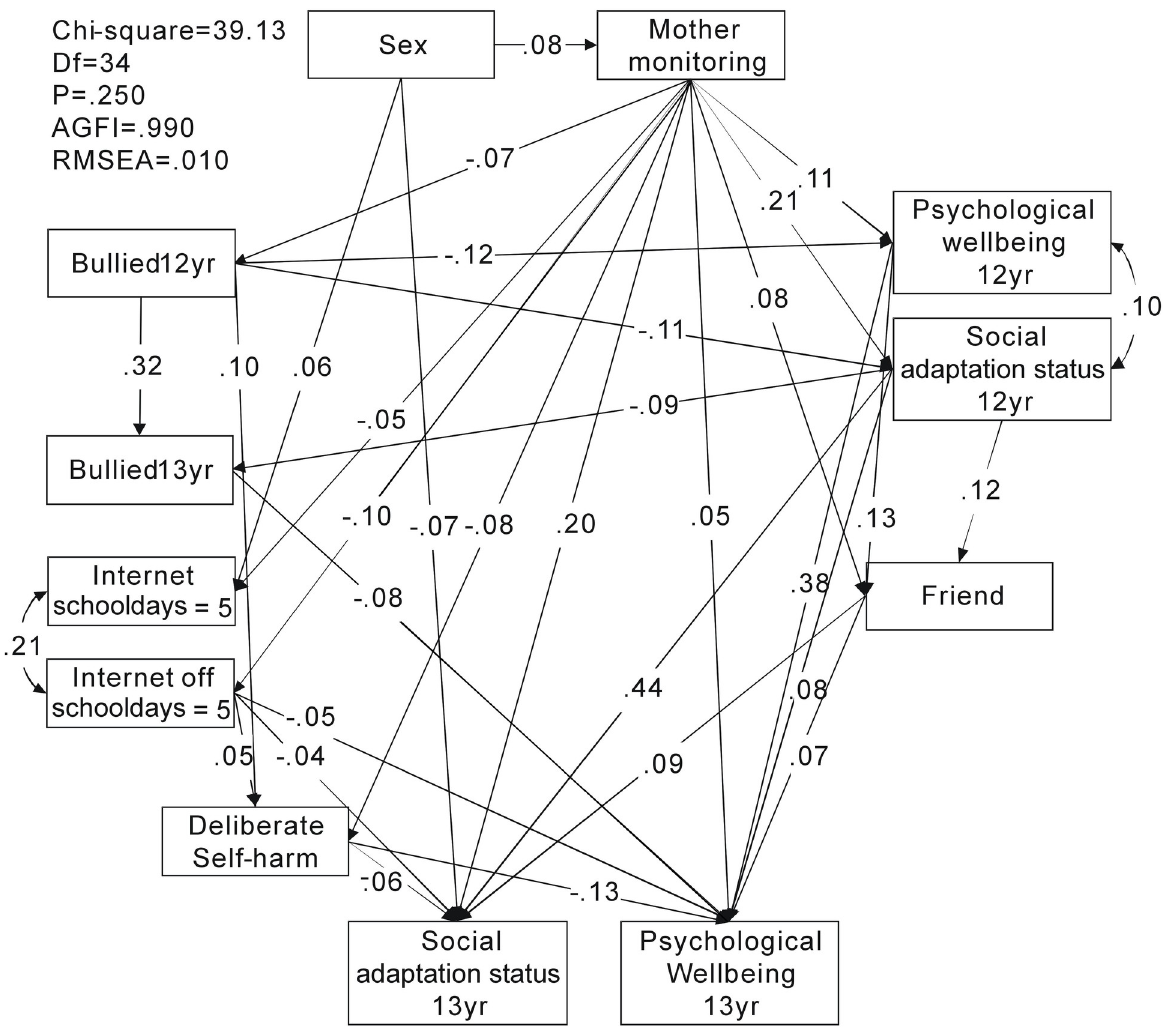
Fig 2. Pathway relationships among maternal monitoring, bullying, internet use > 5 h/day, deliberate self-harm and self-perceived happiness. AGFI: adjusted goodness-of-fit; RMSEA: root mean square error of approximation